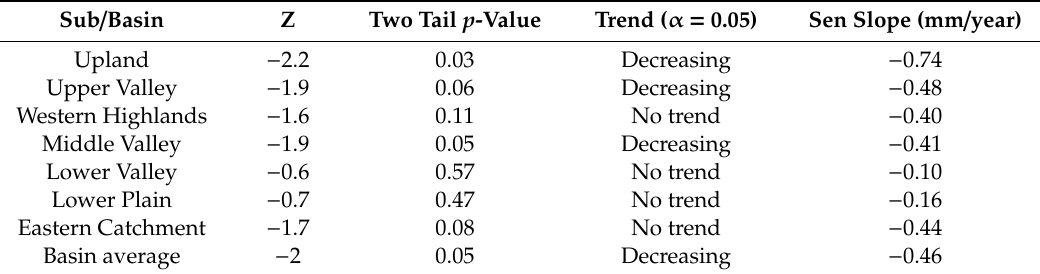
Table 4. Summary trend analysis for summer rainfall.